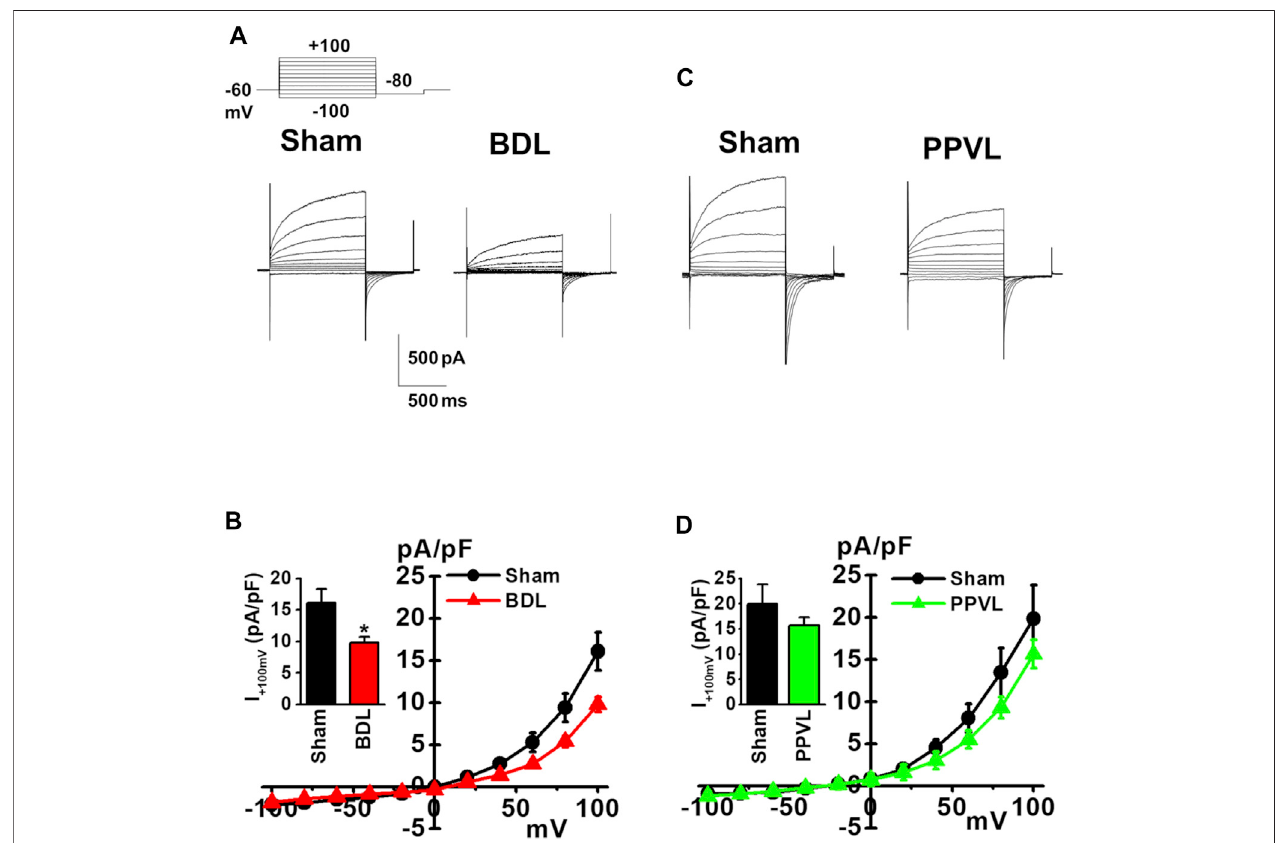
FIGURE 3 | Reduced Cl Ca currents in PVSMCs from BDL mice. Under whole-cell voltage-clamp con fi gurations, freshly isolated PVSMCs were stimulated from a holding potential of − 60 mV to selected test potentials (from − 100 to +100 mV) by 20-mV increments for 1 s and then repolarized to − 80 mV for 500 ms. (A) RepresentativetracesofCl Ca currentsinsham-andBDL-PVSMCs. (B) Current-voltage(I-V)relationshipofCl Ca currentsinsham-andBDL-PVSMCs.Peakamplitudeof outward currents at +100 mV (inset; n = 7 – 12). (C) Representative traces of Cl Ca currents in sham- and PPVL-PVSMCs. (D) Current-voltage (I-V) relationship of Cl Ca currentsinsham-andPPVL-PVSMCs.Peakamplitudeofoutwardcurrentsat+100 mV(inset; n =5 – 7).Dataarepresentedasmeans±S.E.* p < 0.05versussham.